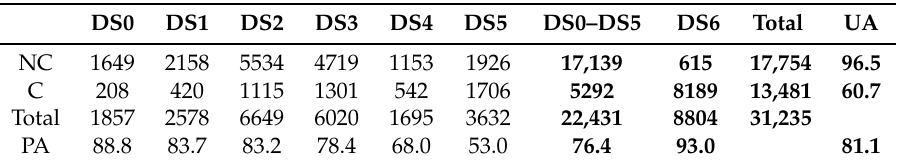
Accuracy evaluation of the classification results for collapsed and non-collapsed buildings obtained using a non-linear discriminant function based on the fragility function of Koshimura et al. [26].